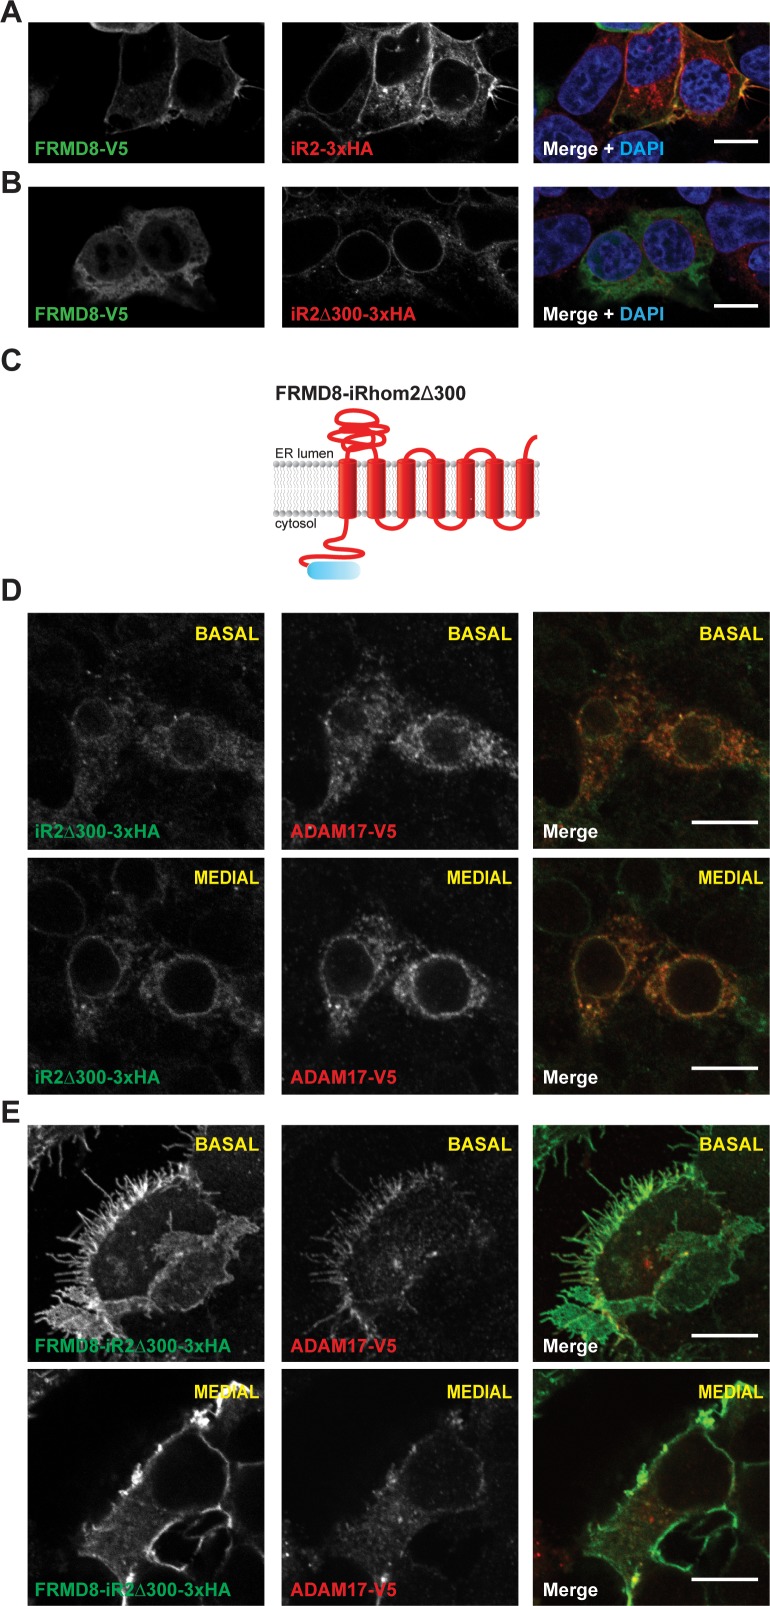
FRMD8 promotes cell surface localisation of iRhom2.(A, B) Immunofluorescence of iRhom1/2 double knockout HEK293T cells stably expressing iRhom2-3xHA or iRhom2Δ300-3xHA and transiently transfected with FRMD8-V5 for 72 hr. Cells were stained for HA (red), V5 (green) and DAPI for DNA (blue). Single confocal sections are shown, taken through the centre of the nucleus. (C) Schematic model of the FRMD8-iRhom2Δ300 construct used in (E). (D, E) Immunofluorescence of iRhom1/2 double knockout HEK293T cells stably expressing iRhom2Δ300-3xHA or FRMD8-iRhom2Δ300-3xHA and transiently transfected with ADAM17-V5 for 72 hr. Cells were stained for HA (green), V5 (red) and DAPI for DNA (blue). Single confocal sections are shown, taken either through the centre of the nucleus (MEDIAL), or at basal regions close to the coverslip (BASAL). In all images the scale bar = 10 µm.